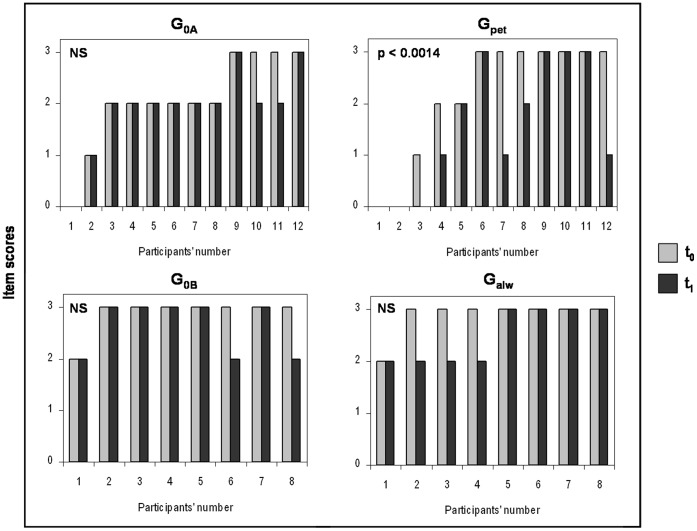
Item scores of “offering to share” at t0 (4-to-5-years old; in grey) and t1 (current period; mean age: 129.9±55.8 months old; in black) for G0A (group with no pet in the family), Gpet (group with a pet arriving after the child’s 5th birthday), G0B (group with no pet in the family) and Galw (group always with at least one pet at home since birth).Higher the score, more significant was the “offering to share” (e.g. sharing food or toys with parents or other children).